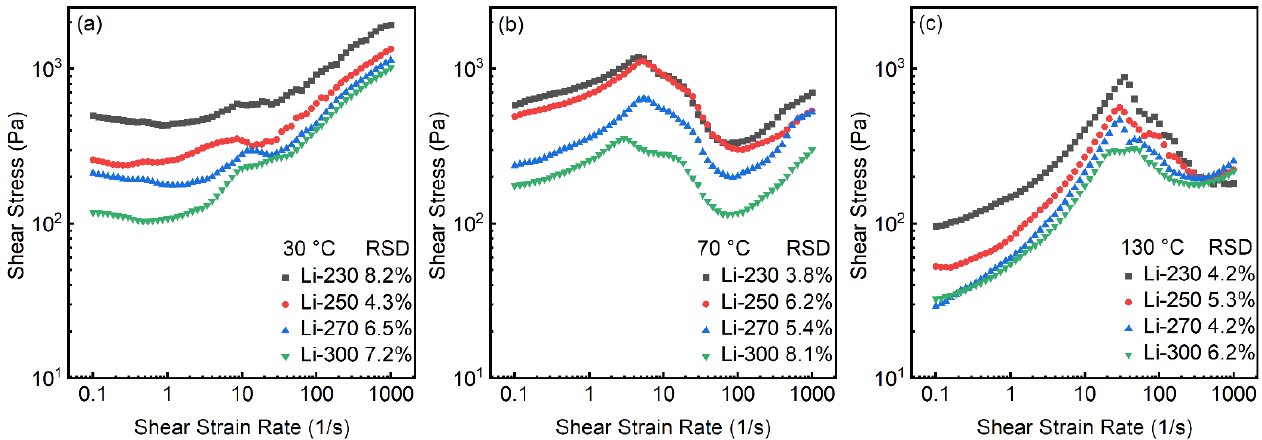
Figure 5. Variations in shear stress of lithium grease with shear strain rate at different temperatures: ( a ) 30 °C, ( b ) 70 °C, ( c ) 130 °C.